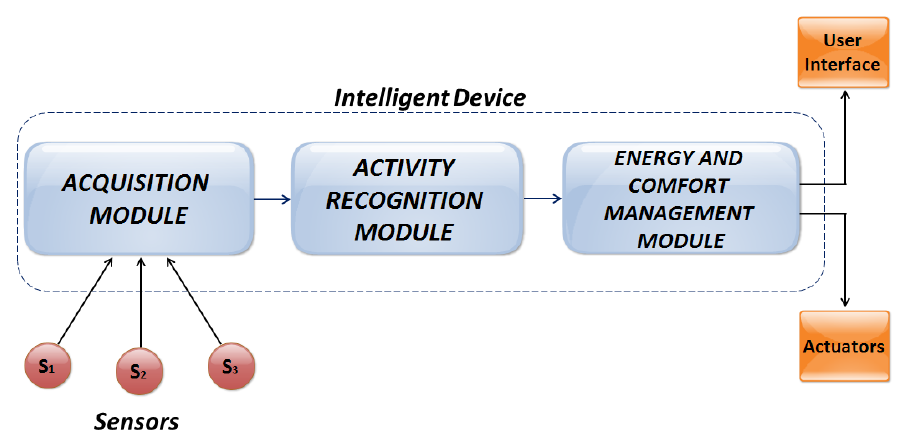
Figure 1. Integration of the activity recognition system inside a BECM system. Table 1. Characteristic parameters of the most typical home appliances